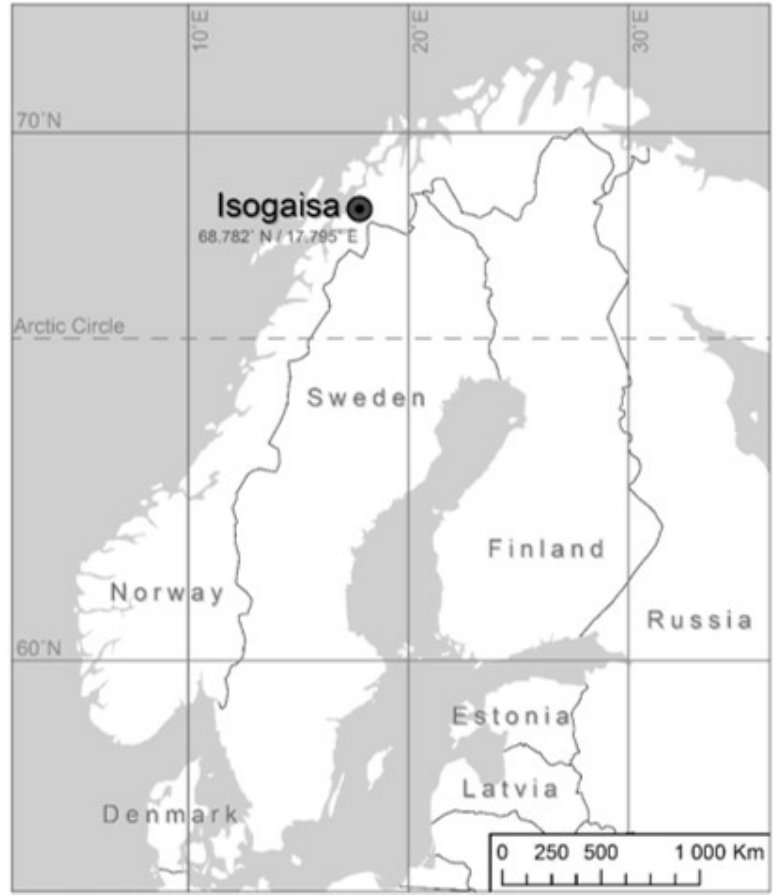
Figure 1. Map of the location of Isogaisa (Map: Wesa Perttola).